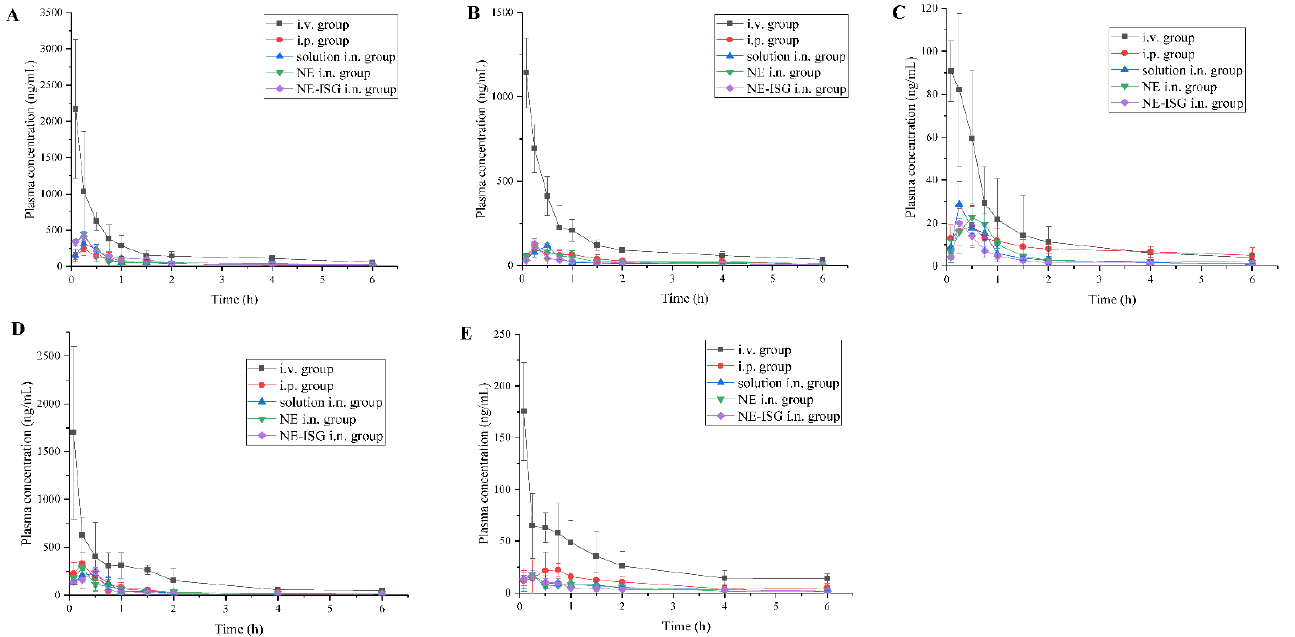
Figure 3. Concentrations of components plasma samples of each group after administration of VOC preparation ( n = 3, X ± SD). ( A ) Senkyunolide A. ( B ) Neocnidolide. ( C ) n-Butylphthalide. ( D ) Z-ligustilide. ( E ) Butenyl phthalide .